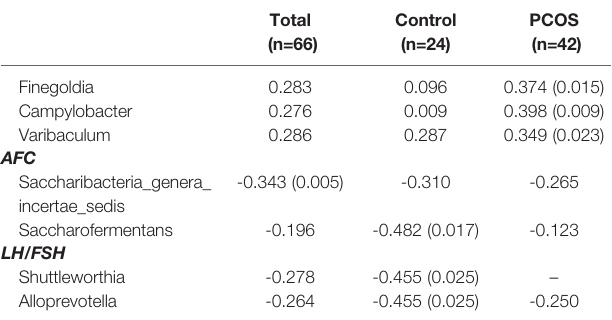
TABLE 3 | Pearson correlation coef fi cient and P value between vaginal microbiome and environmental